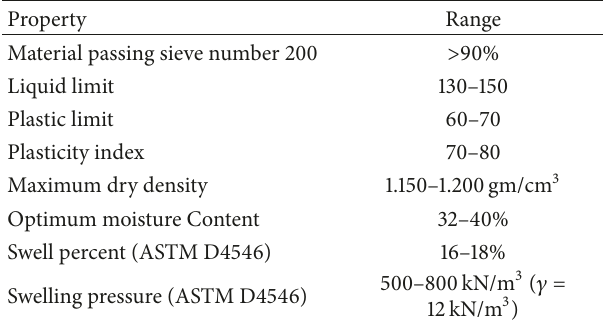
Table 1: Physical properties of Al-Qatif clay.